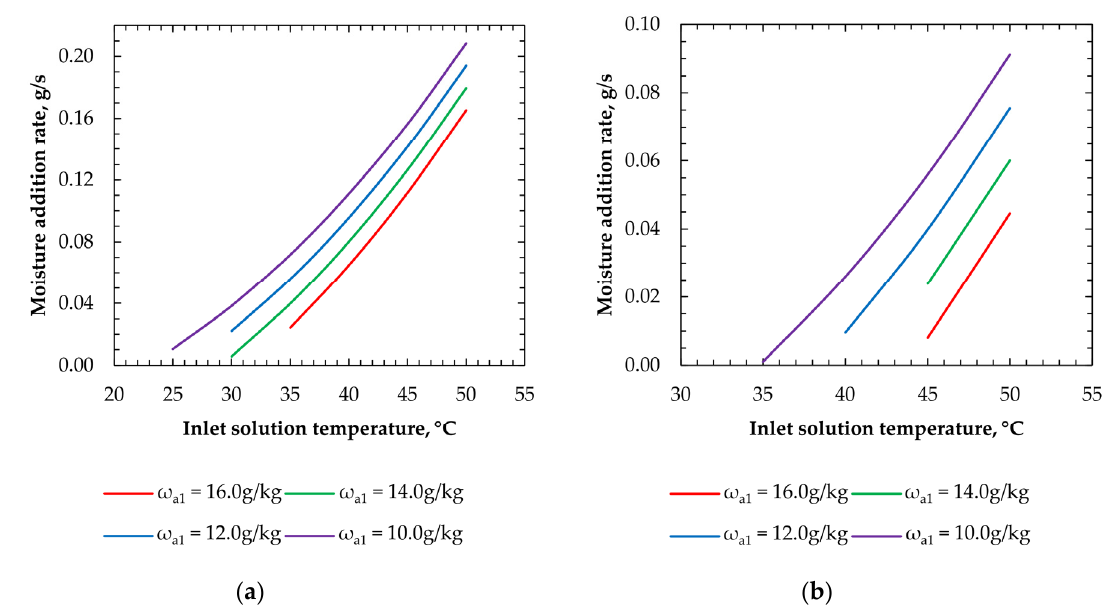
Figure 11. Effect of inlet solution temperature in regard to different inlet air-humidity ratios: ( a ) on moisture addition rate at X 1 = 25%; ( b ) on moisture addition rate at X 1 = 35%.